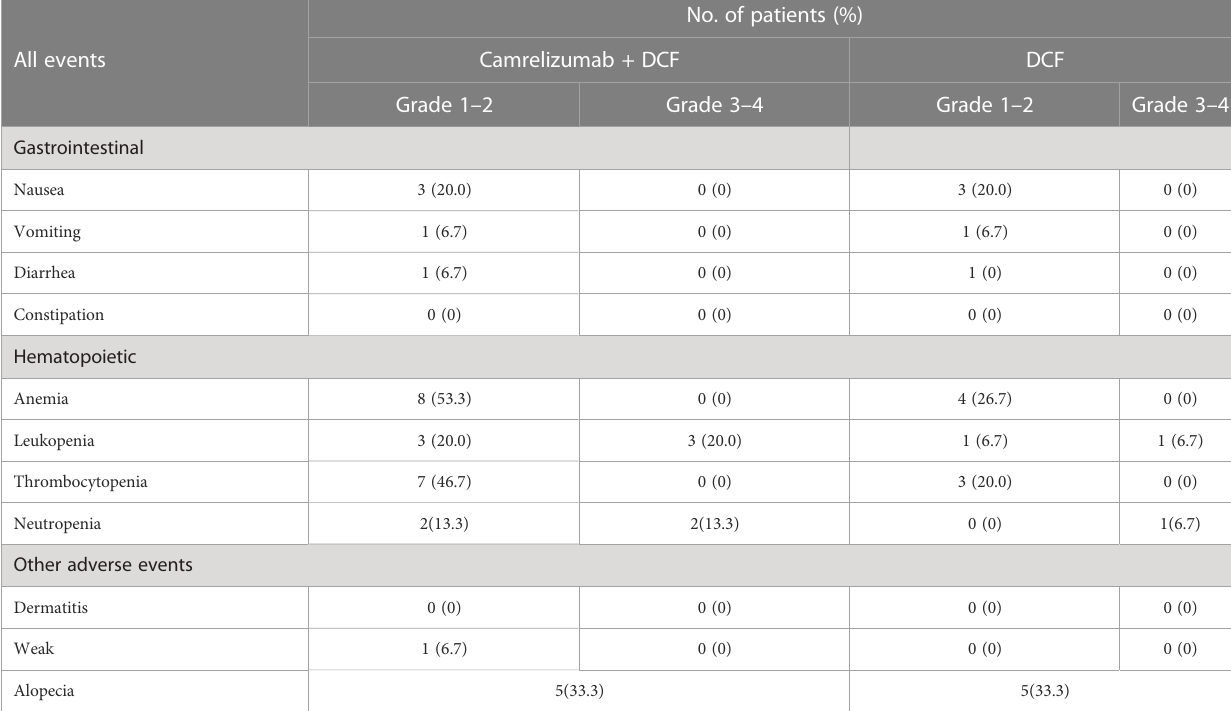
TABLE 3 Adverse events comparison of the two